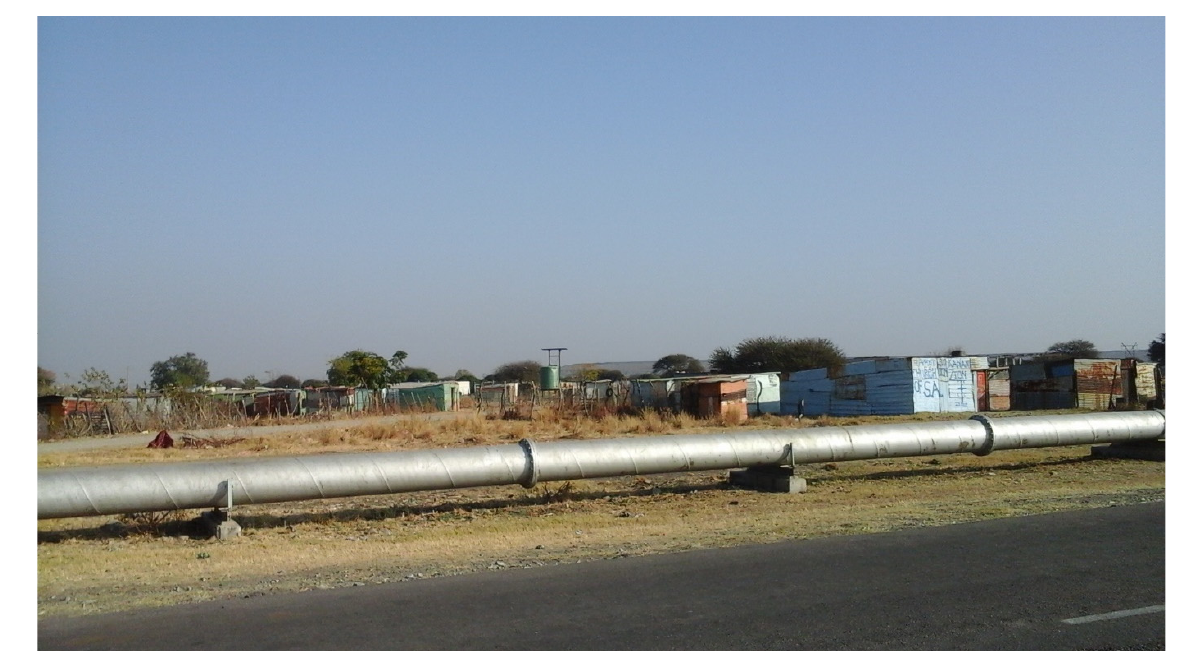
Figure A2. Atlantis Witsand informal settlement in 2015, Western Cape, South Africa.